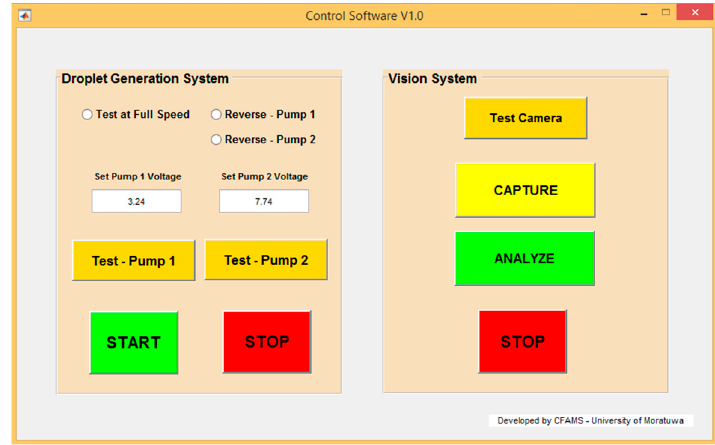
Figure 8. Front-end of the GUI.